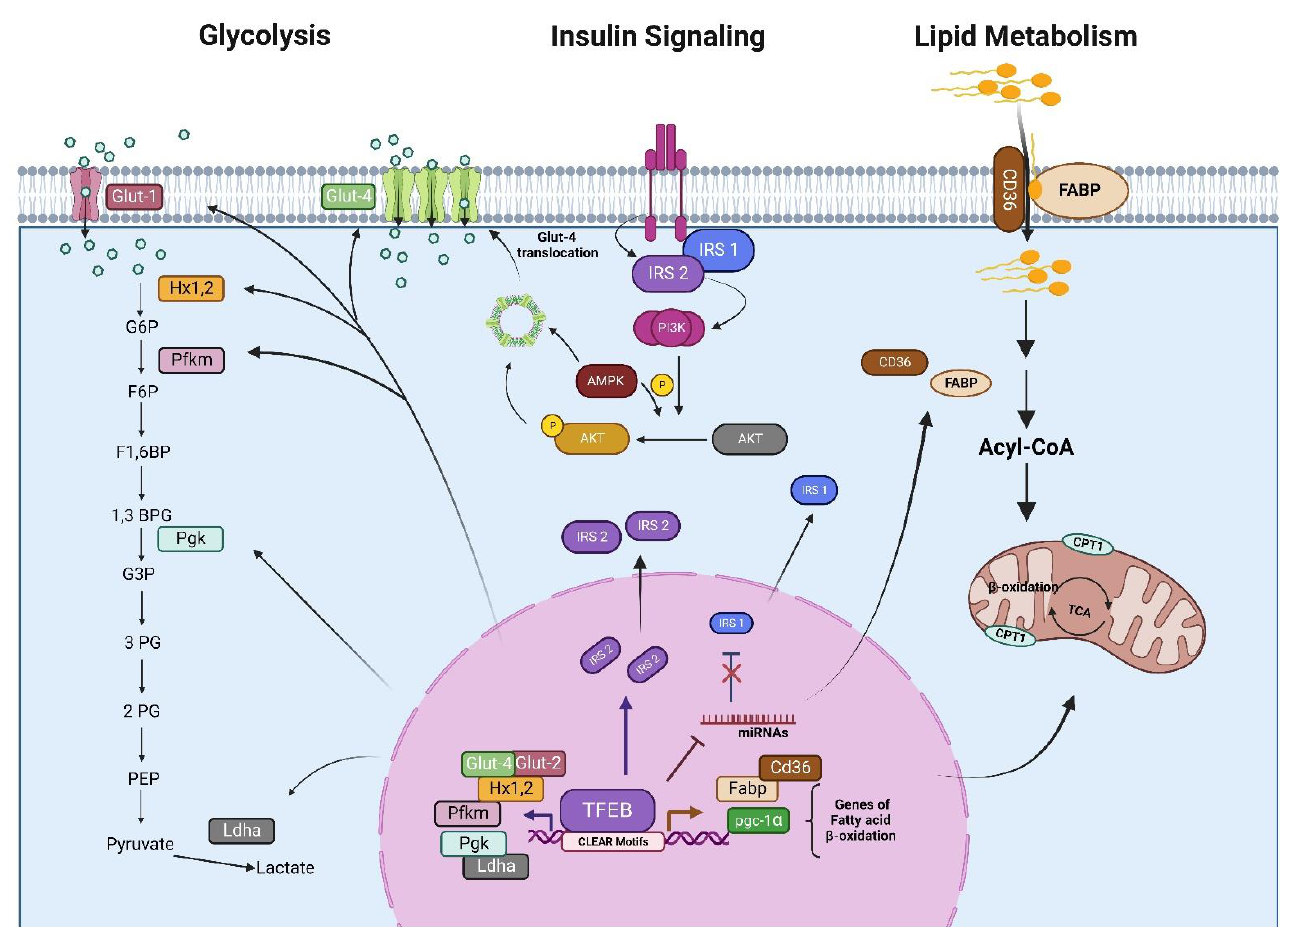
Figure 4. The TFEB regulates genes involved in carbohydrate metabolism, lipid metabolism, and insulin signaling. Once active, TFEB may promote energy utilization through the activation of several related genes. Some of the proposed metabolic processes regulated by TFEB are shown, together with the relevant substrates.